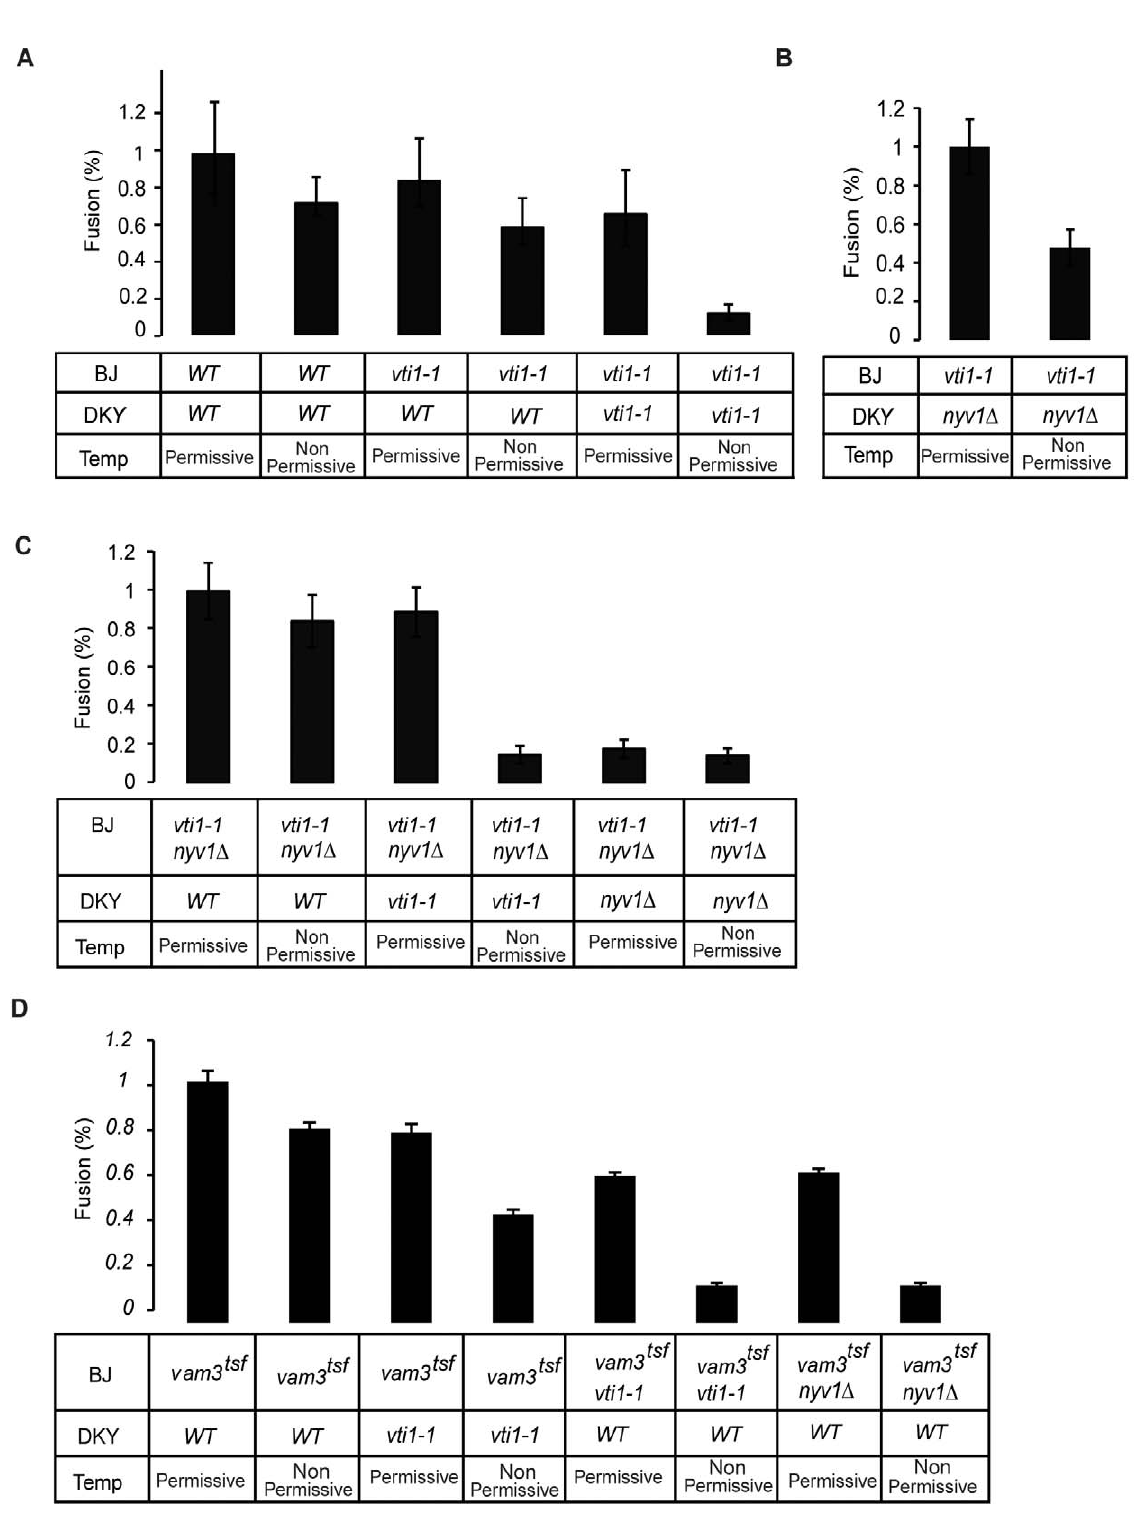
Figure 2. Inactivation of SNAREs by conditional alleles to create unidirectional trans -SNARE complexes. Vacuoles were isolated from BJ3505 (BJ) and DKY6281 (DKY) strains carrying the indicated temperature-sensitive alleles. The spheroplasting step of vacuole isolation was performed at 25 u C (25 min, permissive) in order to leave the temperature-sensitive protein intact, or at 40 u C (12.5 min for DKY, 25 min for BJ, non- permissive) to inactivate it. Isolated vacuoles were used in standard fusion reactions as indicated. Five independent experiments were averaged. Error bars indicate the standard deviation.